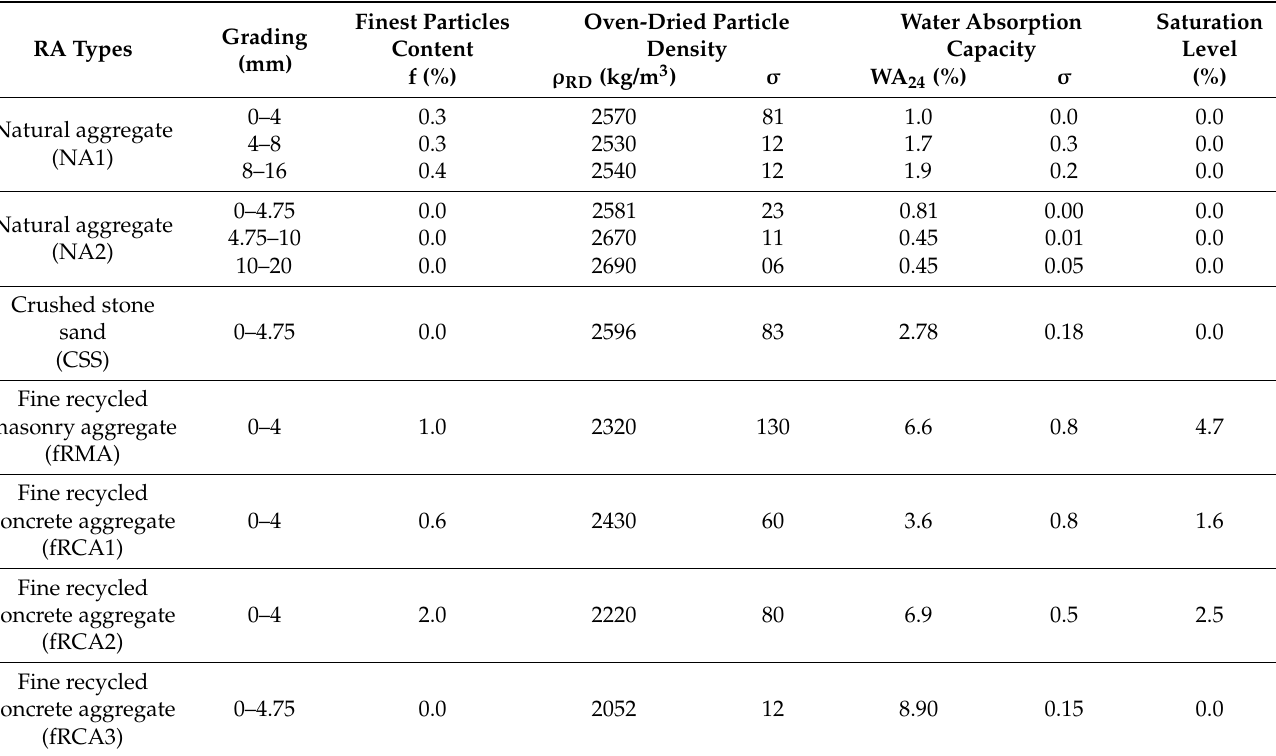
Table 1. The basic physical properties of each fraction of aggregates used for concrete mixtures.